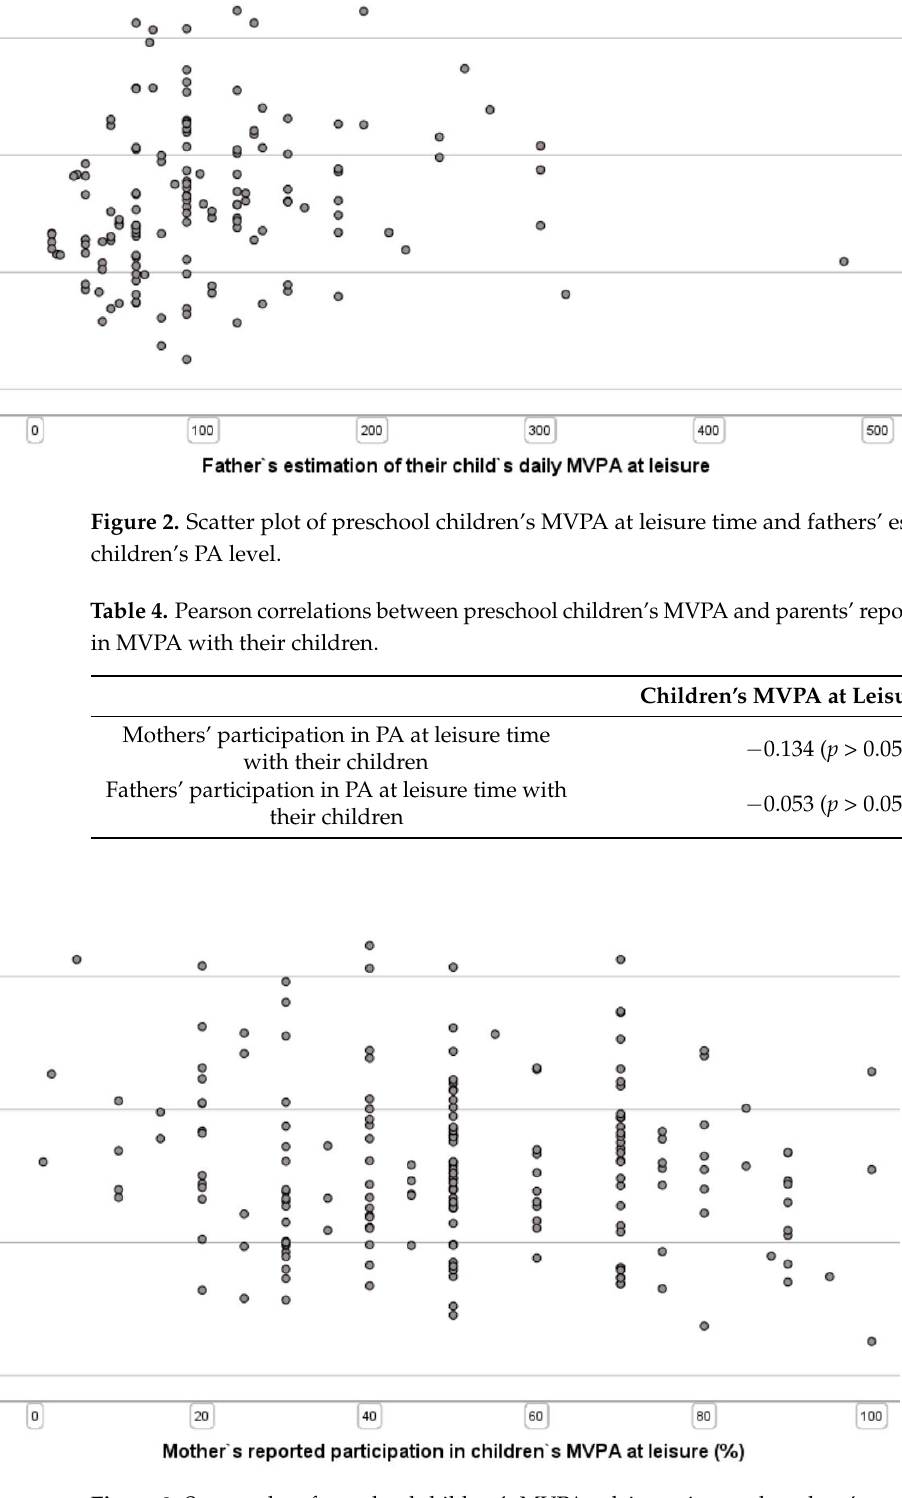
Figure 4. Scatter plot of preschool children’s MVPA at leisure time and fathers’ reported participa- tion in MVPA with their children. On average, the results demonstrate that mothers estimate that they participate in their children’s PA 50.8% of the time, whereas fathers estimate that they participate in their children’s PA 44% of the time.